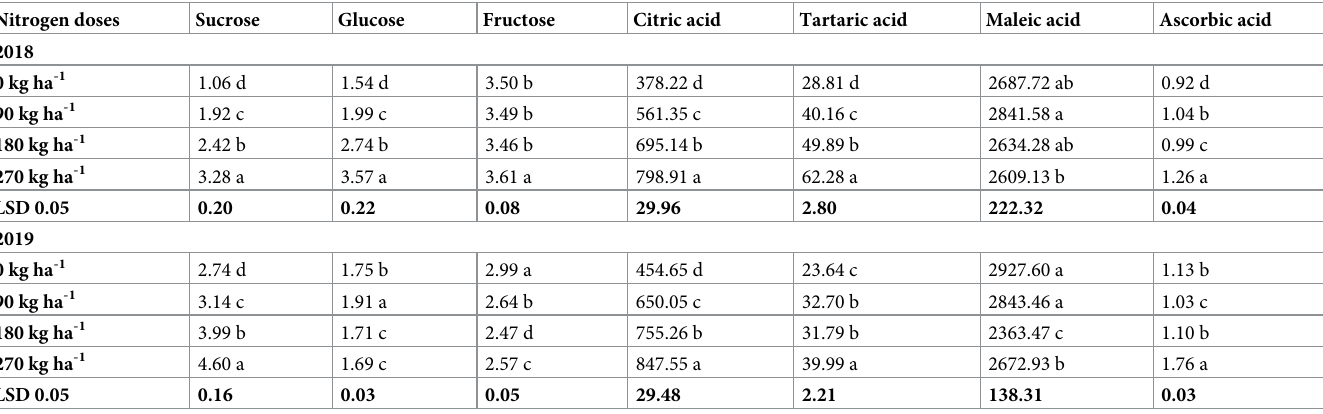
Table 5. The impact of different nitrogen doses on the quality attributes of grafted watermelon grown under climatic conditions of C¸ukurova region. Nitrogen doses Sucrose Glucose Fructose Citric acid Tartaric acid Maleic acid Ascorbic